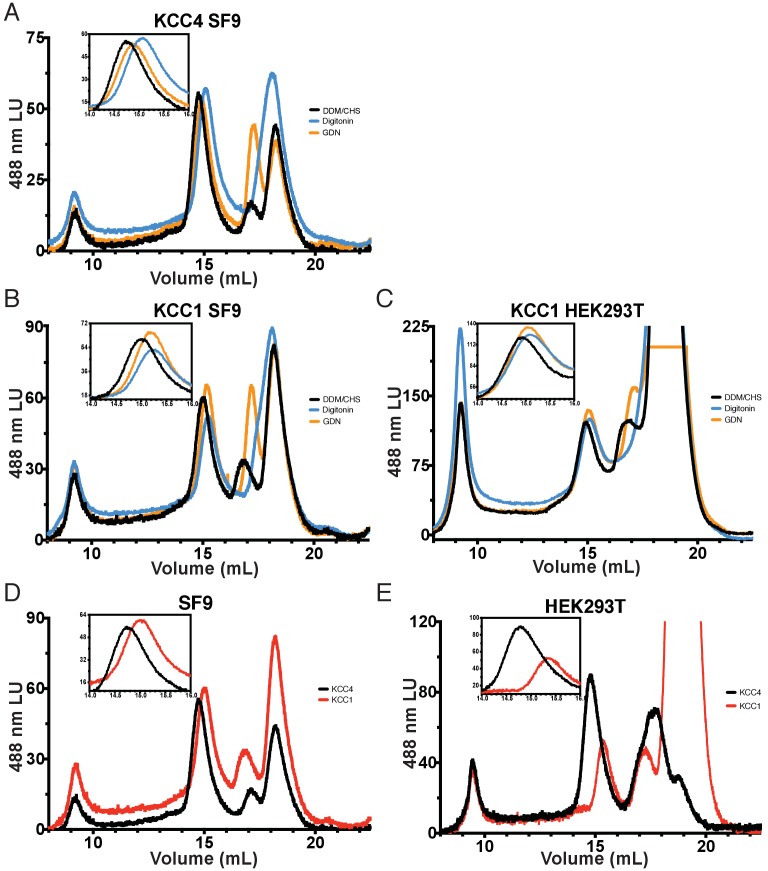
FSEC comparison of KCC4 and KCC1 expressed in different host cells and treated with different detergents.(A) Overlaid fluorescence chromatograms from a Superose six gel filtration of KCC4 expressed in SF9 cells and extracted/run in DDM:CHS/DDM:CHS (black; conditions used in KCC4 structure determination) DDM:CHS/GDN (orange; conditions used in KCC1 structure determination), and LMNG/digitonin (blue; conditions used in NKCC1 structure determination). (B) As in (A), but for KCC1 expressed in SF9 cells. (C) As in (A), but for KCC1 expressed in HEK293T cells. (D) Overlaid fluorescence chromatograms of KCC4 (black) and KCC1 (red) expressed in SF9 cells and extracted/run in DDM:CHS/DDM:CHS. (E) As in (D), but for KCC4 (black) and KCC1 (red) expressed in KEK293T cells.